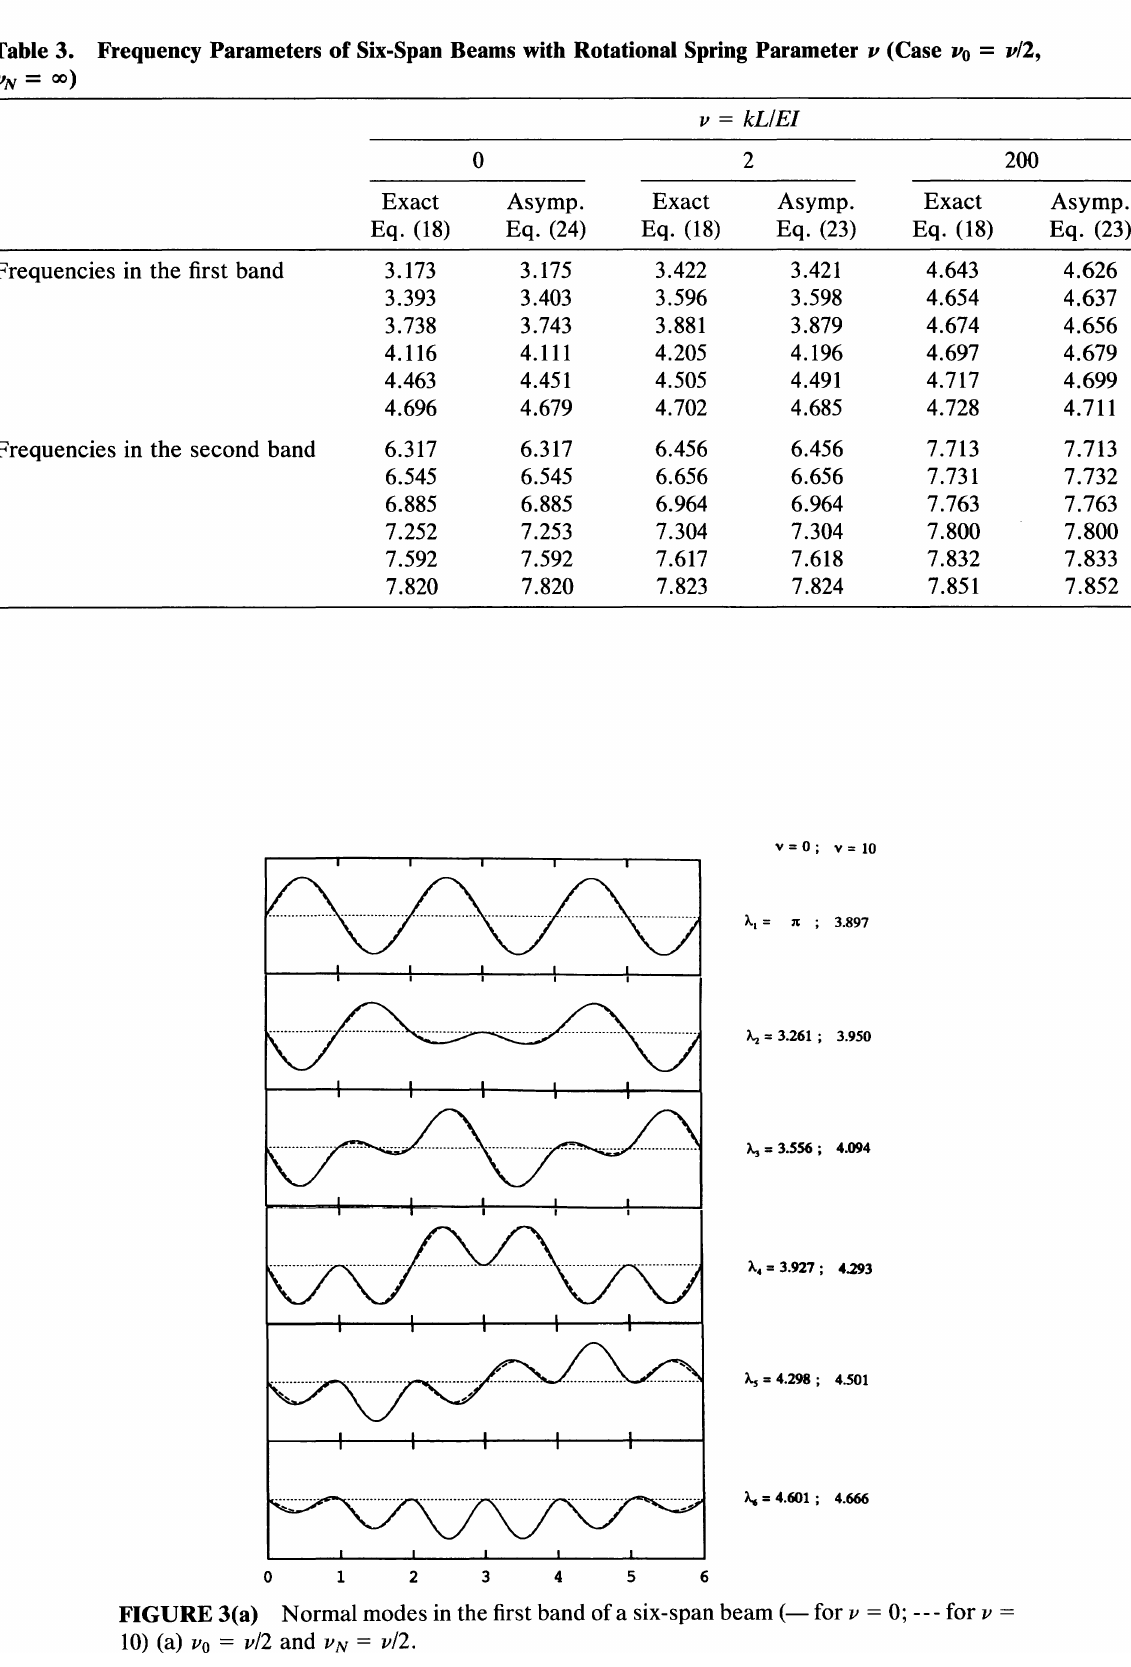
Table 3. Frequency Parameters of Six-Span Beams with Rotational Spring Parameter v (Case Vo = v/2, = 00) VN